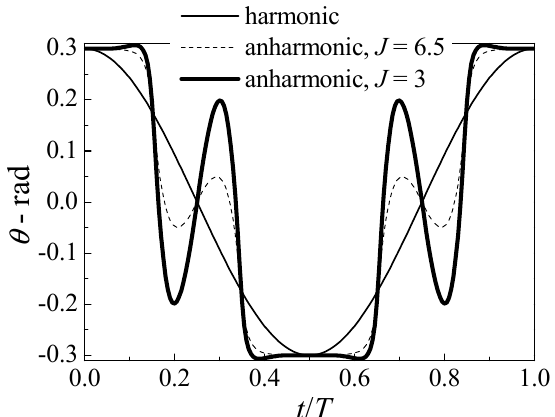
Figure 4. Harmonic and anharmonic ( n = 1) Y-direction displacement ( left ) and heave velocity curves ( right ).